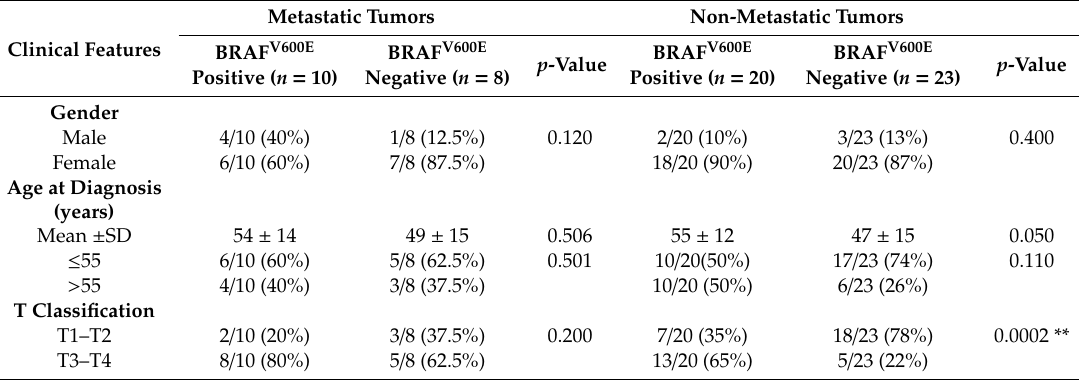
Table 2. Clinical features of metastatic and non-metastatic PTC tumors with or without BRAF V600E mutation, ** p <